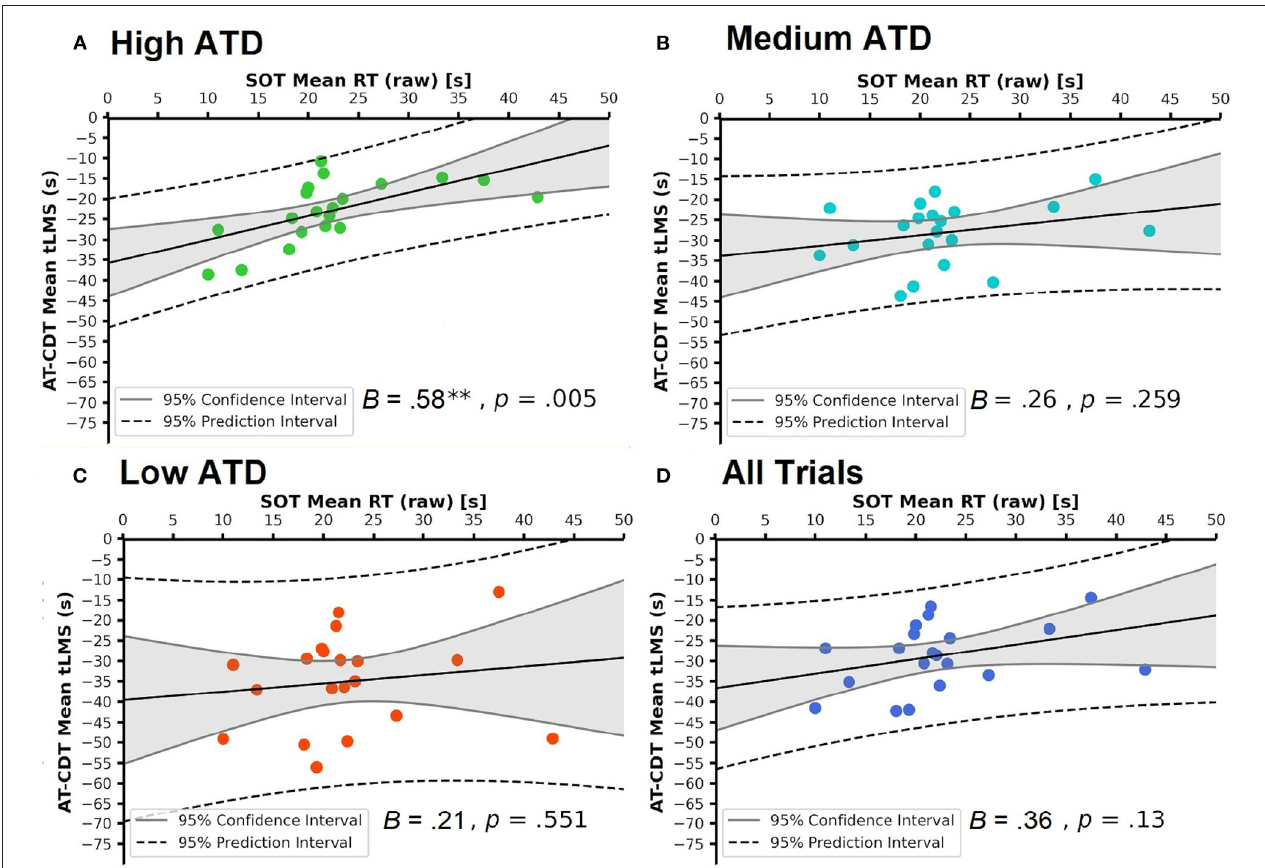
FIGURE 7 | Scatter-plots showing the linear relationships between mean Spatial Orientation Test (SOT) raw reaction time (RT) and mean Air Traffic Conflict Detection Task (AT-CDT) time to loss of minimum separation (tLMS) under each of (A–C) three air traffic density (ATD) conditions and over (D) all AT-CDT test trials. Raw regression coefficients are shown. (A) shows the significant correlation emanating from the high ATD condition. Ninety five percent confidence and prediction intervals are shown. In all plots, no data points lie beyond the 95 % prediction interval, showing the absence of